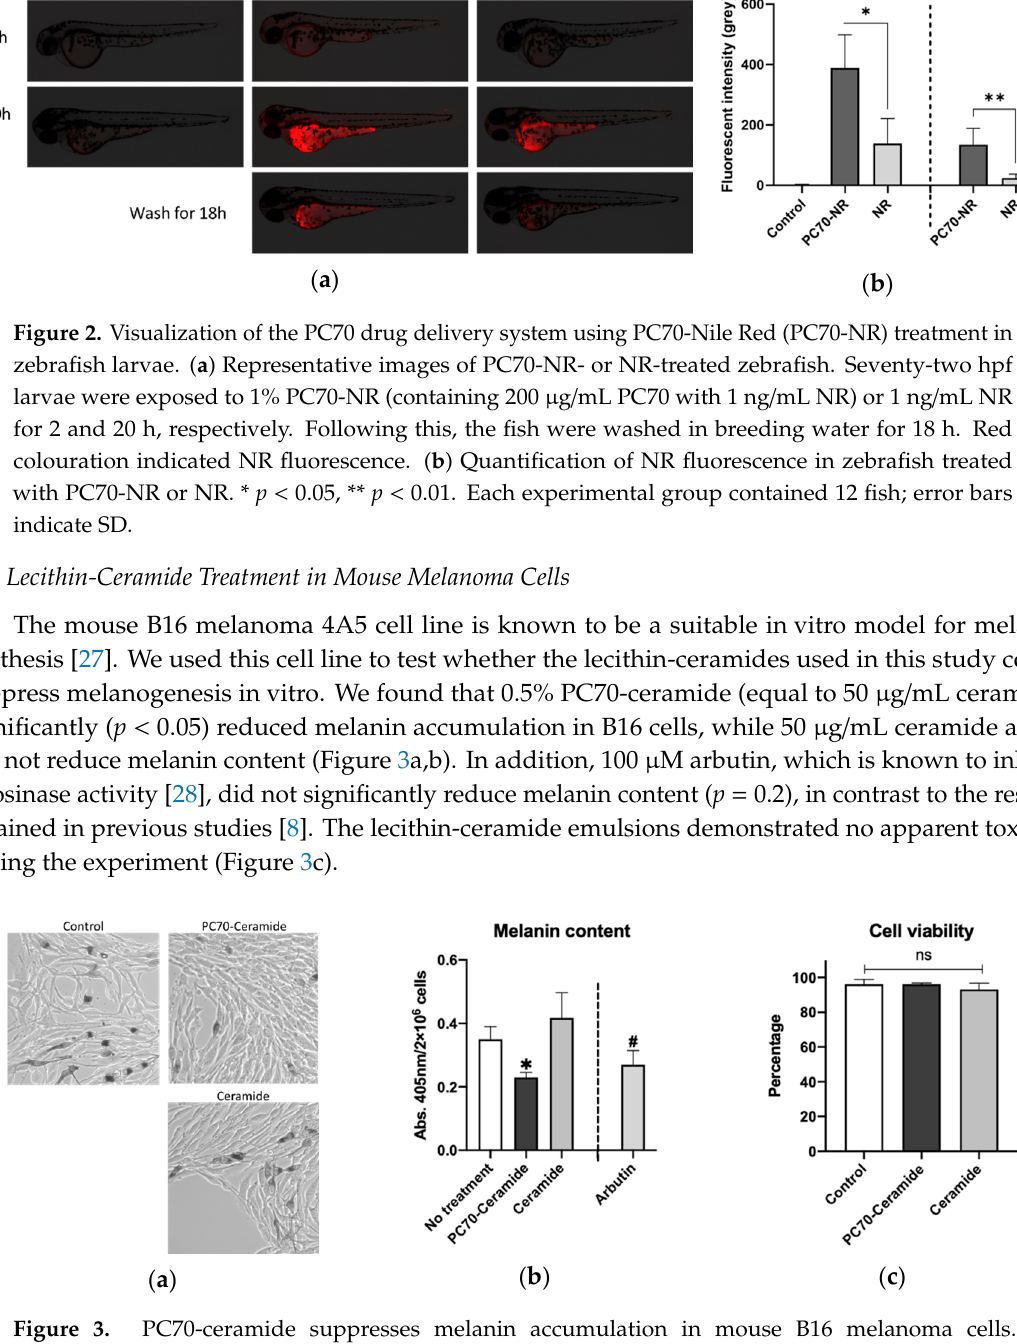
Figure 3. PC70-ceramide suppresses melanin accumulation in mouse B16 melanoma cells. ( a ) Representative images of B16 cells treated with PC70-ceramide or ceramide. B16 4A5 cells were treated with 0.5% PC70-ceramide (containing 50 µg/mL ceramide) or 50 µg/mL ceramide for 48 h. ( b ) Melanin levels of B16 cells treated with PC70-ceramide, ceramide, or arbutin. Arbutin was used as a positive control, following the method used by a previous study [8]. * p < 0.05, # p < 0.1 vs. control. n = 3, error bars indicate SD. ( c ) Cell viability of B16 cells treated with PC70-ceramide or ceramide. “ns” indicates no significance. n = 3, error bars indicate SD.